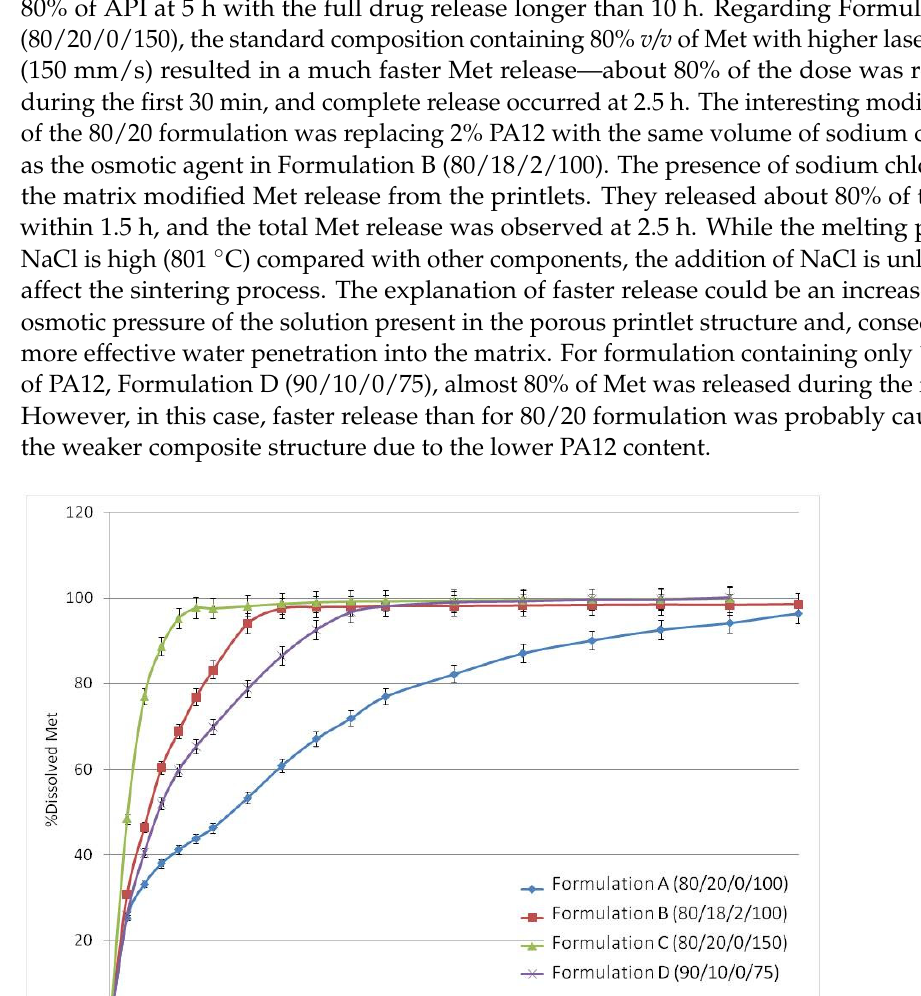
Figure 9. Flotation of Formulation C (80/20/0/150) in USP4 apparatus after 10 h of the experiment.